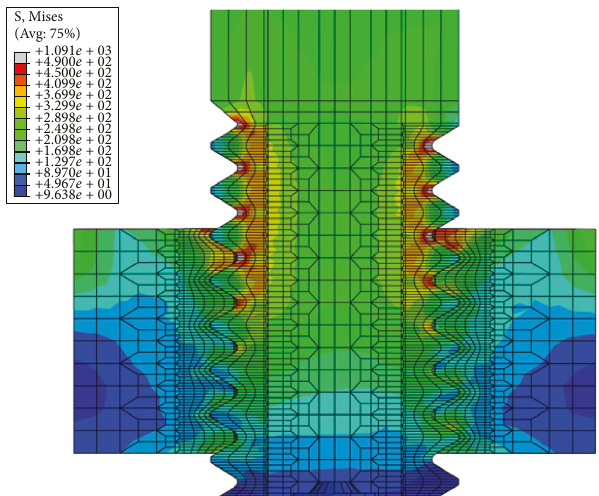
Figure 8: Detailed bolt section stress.